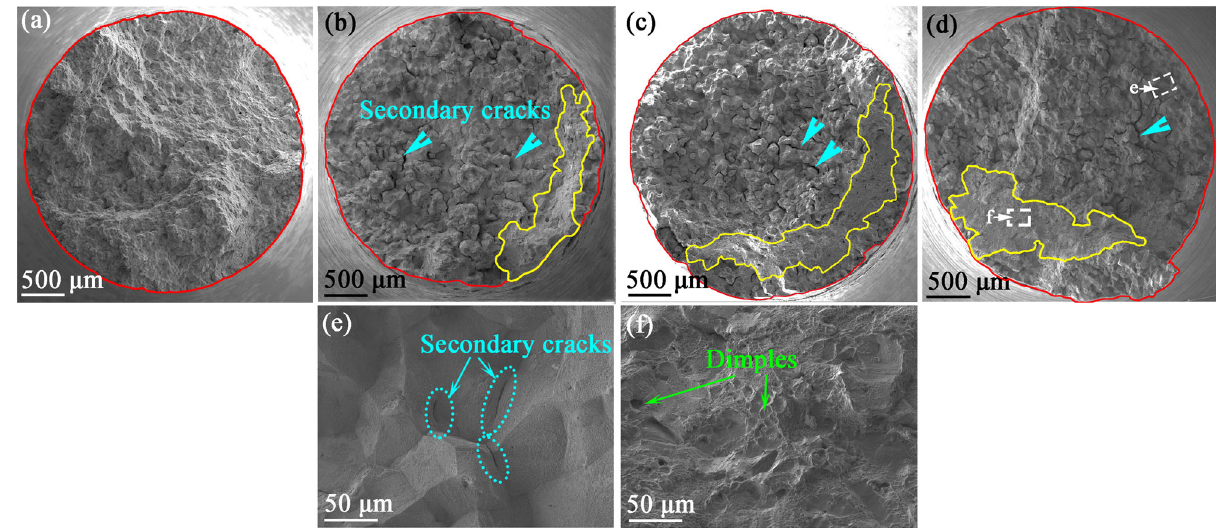
Fig. 3 Fractographies. a A0: 0Al-0.6Nb, b A1: 2.5Al-0.6Nb, c A2: 3.5Al-0.6Nb, d A3: 3.5Al-1Nb, e IGSCC pattern, and f ductile pattern in the white frame in ( d